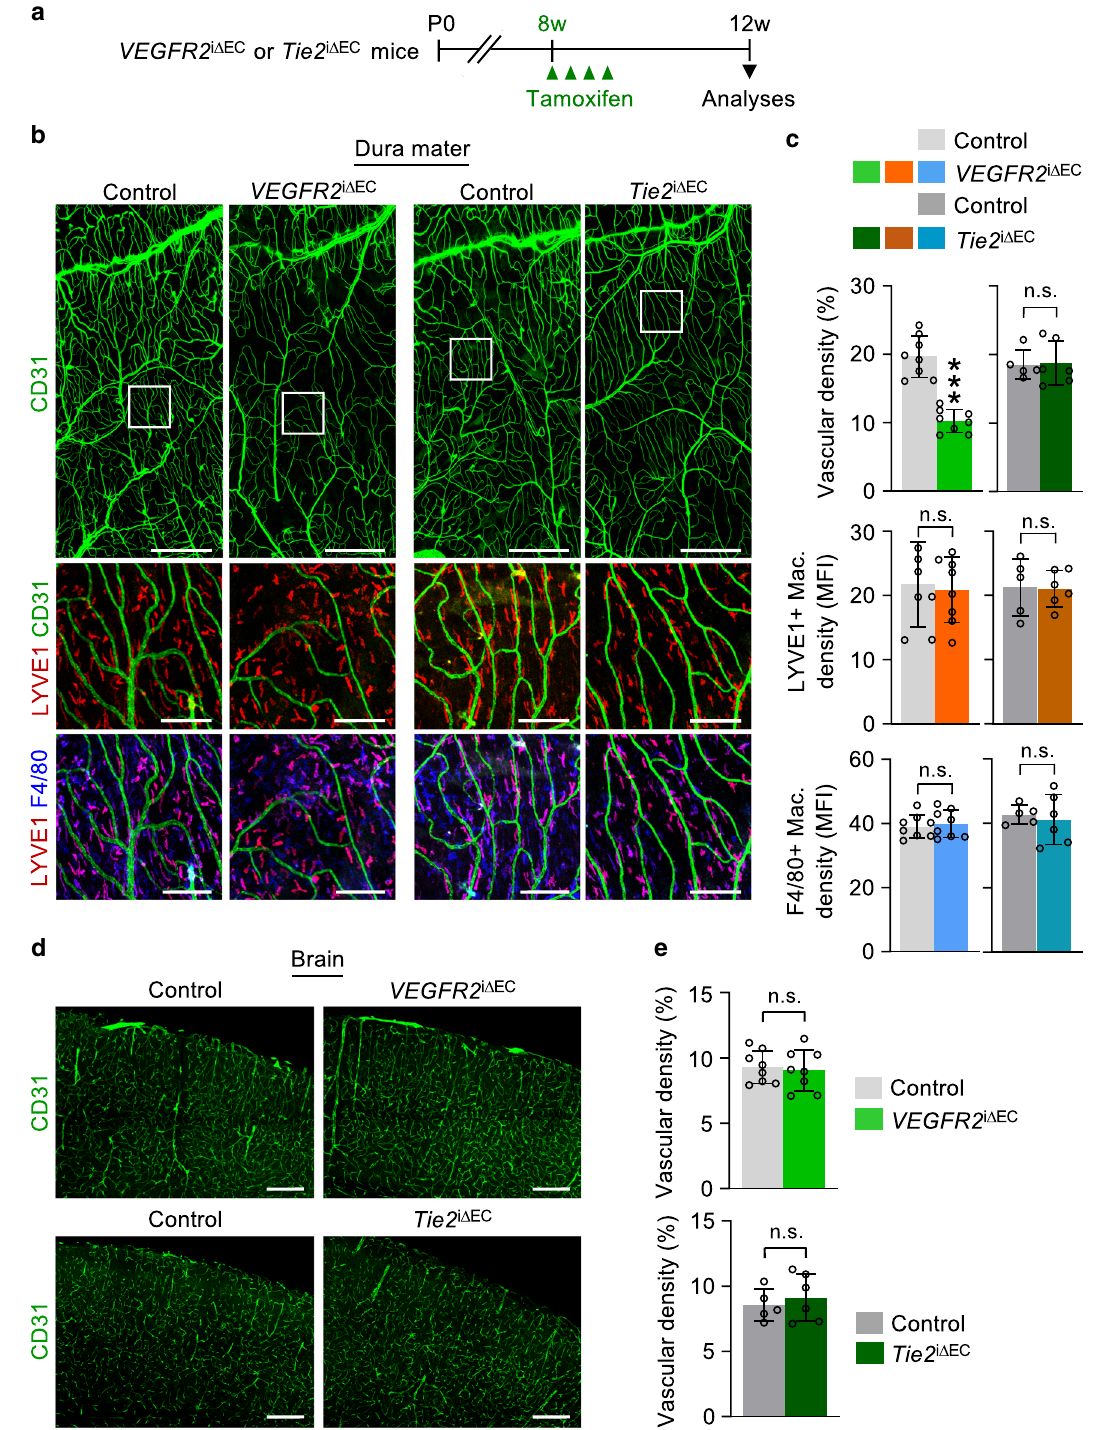
Fig. 6 VEGFR2, but not Tie2, signaling is required for maintaining dural vascular homeostasis. a Diagram depicting generation of VEGFR2 i Δ EC or Tie2 i Δ EC mice and EC-speci fi c deletion of VEGFR2 or Tie2 at 8 weeks old of age and their analyses 4 weeks later. b Representative images of CD31 + BVs (upper panels) and distributions of LYVE1 + (middle and lower panels) and F4/80 + macrophages (lower panels) in dura mater of control, VEGFR2 i Δ EC and Tie2 i Δ EC mice. Scale bars, 1 mm. Each white-lined box is magni fi ed in middle and lower panels. Scale bars, 200 µ m. c Comparisons of densities of CD31 + BVs, LYVE1 + macrophages and F4/80 + macrophages in control and VEGFR2 i Δ EC or Tie2 i Δ EC mice. Each dot indicates a value from one mouse and n = 5 ( Tie2 control), n = 6 ( Tie2 i Δ EC ), n = 8 (all other groups) mice/group from three independent experiments. Vertical bars indicate mean ± SD. n.s., not signi fi cant or *** P < 0.001 versus control by two-tailed Mann – Whitney U test. MFI, mean fl uorescence intensity. d , e Representative images of CD31 + BVs in brain of control, VEGFR2 i Δ EC , and Tie2 i Δ EC mice. Scale bars, 200 µ m. Comparisons of vascular density between control and VEGFR2 i Δ EC or Tie2 i Δ EC mice. Each dot indicates a value from one mouse and n = 5 ( Tie2 control), n = 6 ( Tie2 i Δ EC ), n = 8 (all other groups) mice/group from three independent experiments. Vertical bars indicate mean ± SD. n.s., not signi fi cant versus control by two-tailed Mann – Whitney U